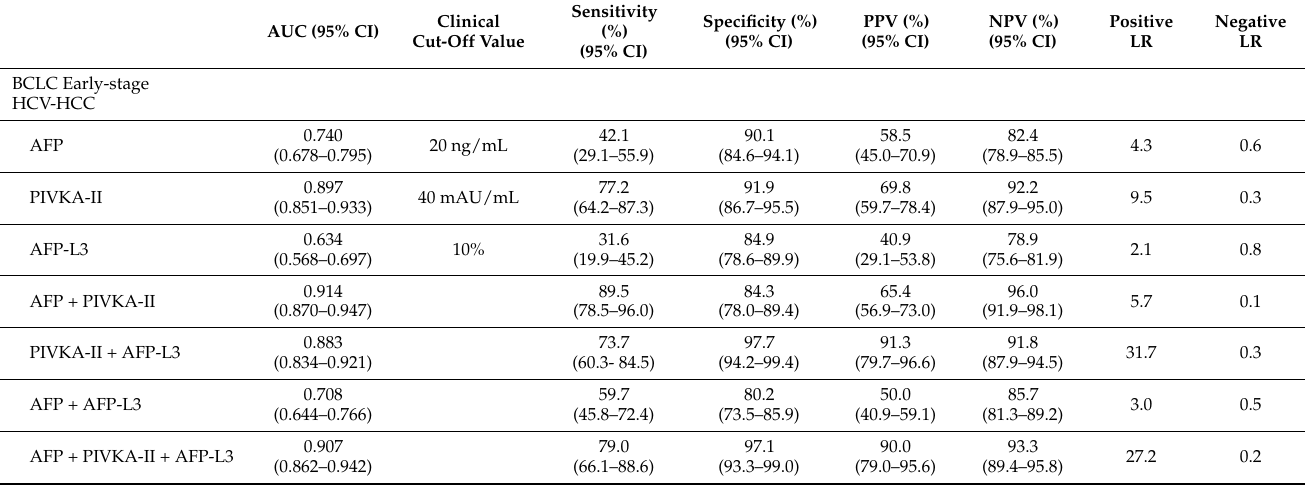
Table 3. Three serum biomarkers for the detection of early-stage HCV-induced